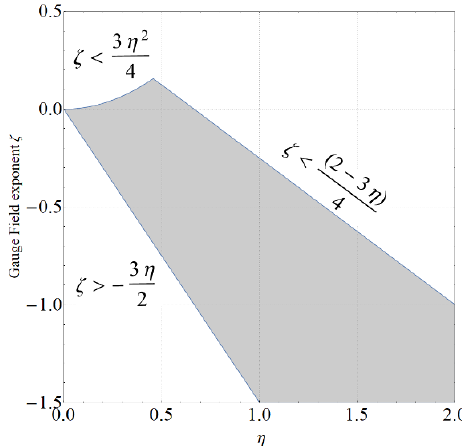
Figure 9. The shaded region represents the allowed values of the parameter (cid:16) for di(cid:11)erent values of (cid:17) . The Chern-Simons term does not constrain the parameter space, due to the simplicity of our electric (cid:12)eld-only